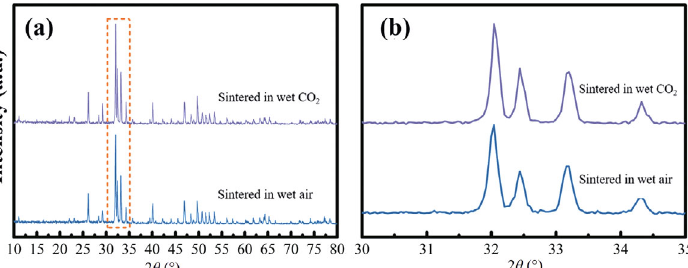
Fig. 7 (a) XRD spectra of the HA samples sintered at 1300 in different sintering atmospheres and (b) partial enlargement ℃ ranges from 30° to